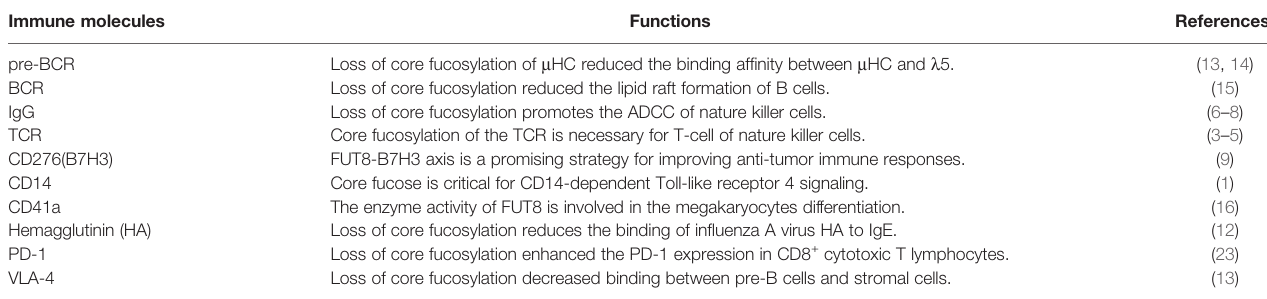
TABLE 1 | Core fucosylated immune molecules and their crucial functions. Immune